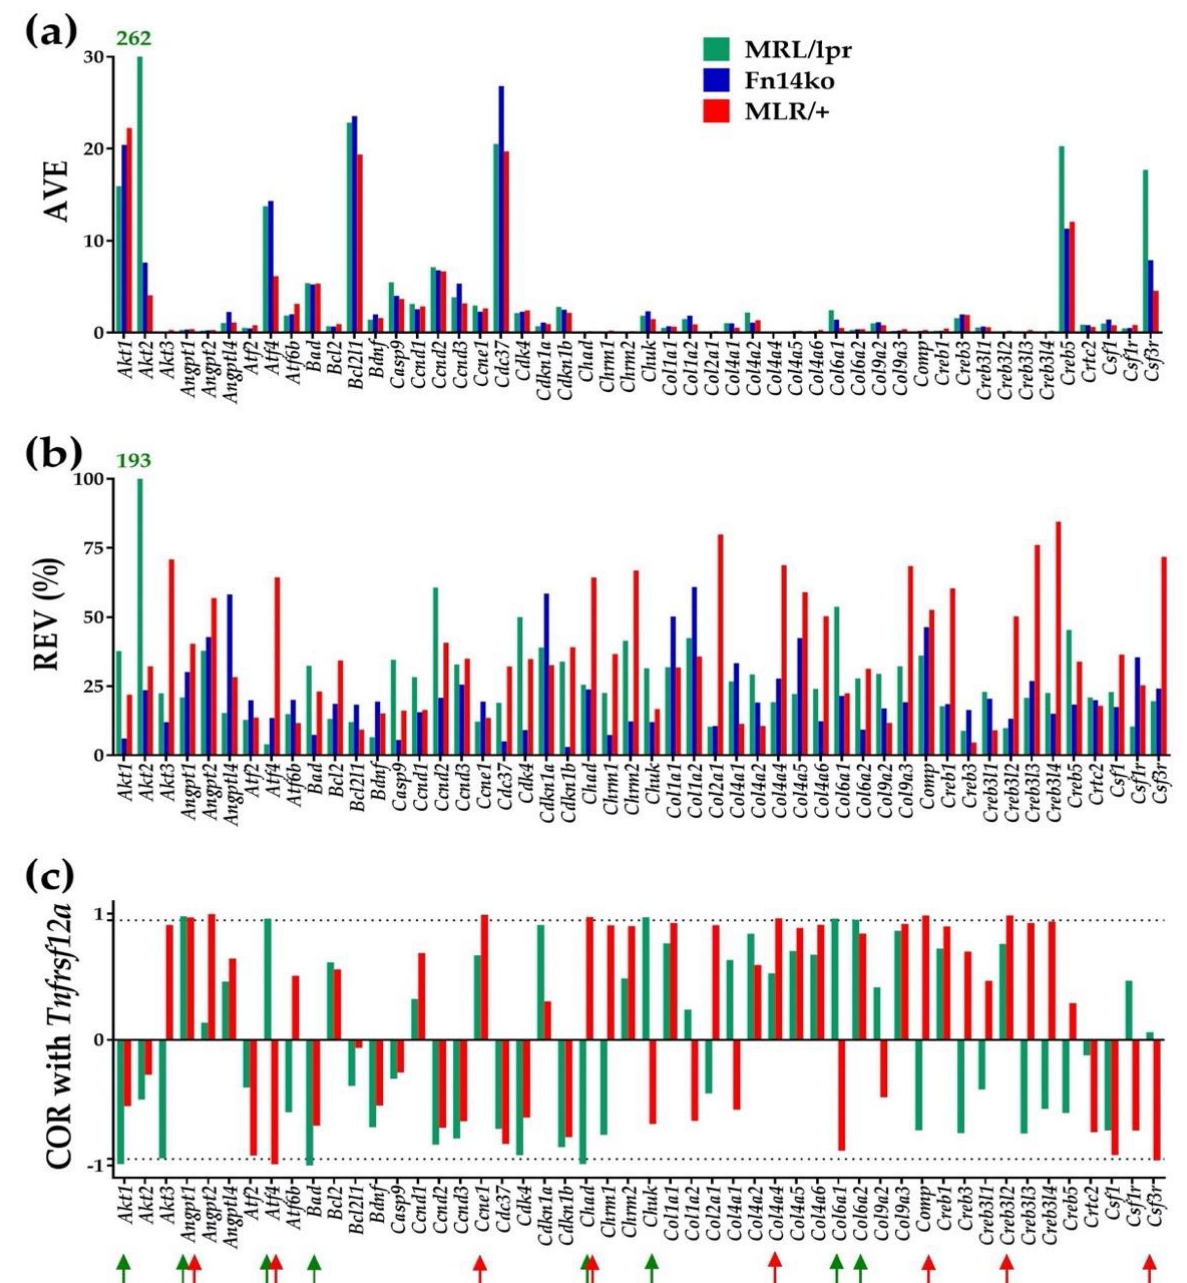
Figure 1. The independent characteristics of the first 50 alphabetically ordered hippocampal PI3K-AKT genes in the three phenotypes. ( a ) Average expression level (AVE); ( b ) Relative expression variability (REV); ( c ) Pair-wise product-momentum correlation coefficient (COR) of PI3K-AKT genes with Tnfrsf12a. Red/green arrows indicate the statistically significant ( p < 0.05) correlations in the MRL/lpr and MRL/+ mice. With AVE = 262 and REV = 193, Akt2 is the most remarkable gene of the selection in the hippocampus of the MRL/lpr mice.